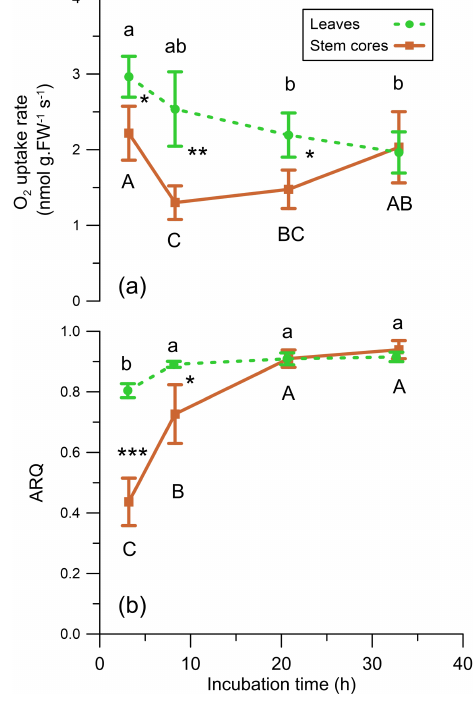
Figure 9. (a) O 2 uptake rate (nmolgFW − 1 s − 1 ) and (b) ARQ (ratio CO 2 increase / O 2 decrease) of Q. ilex leaves and stem cores incu- bated in a closed system ( n = 4). Values are means ± SD. Aster- isks indicate significant difference between tissues at each time step ( ∗ P < 0 . 05, ∗∗ P < 0 . 01, ∗∗∗ P < 0 . 0001 in a Student’s t test). Different letters indicate significant difference in Tukey–Kramer HSD analysis that followed one-way analysis of variance (ANOVA) within tissue type, between time